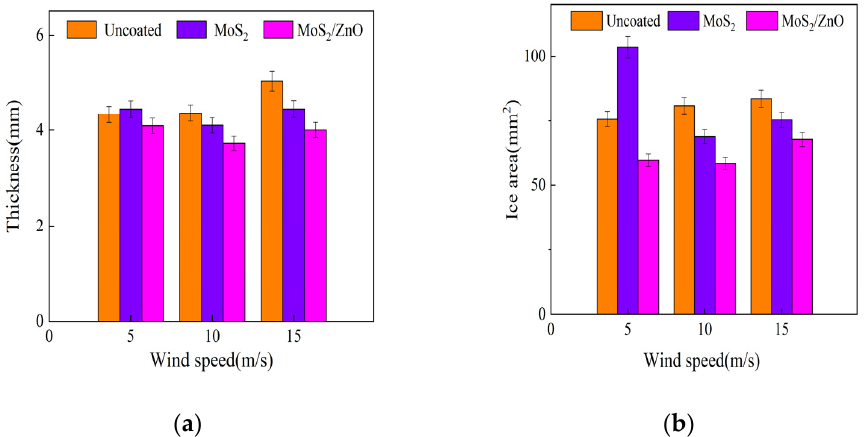
Figure 15. Icing conditions of blade leading edges coated with different materials at − 10 °C ambient temperatures with various wind speeds: ( a ) icing thickness ( b ) icing area.